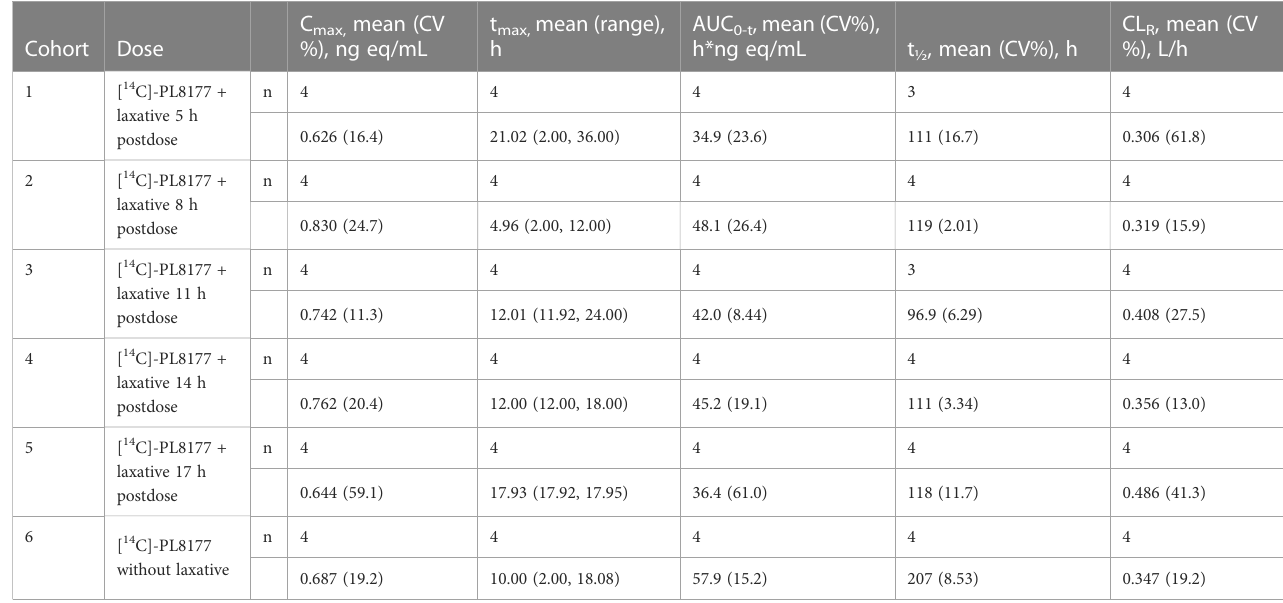
TABLE 3 Plasma PK parameters for total radioactivity in human participants by cohort in phase 0 clinical study.